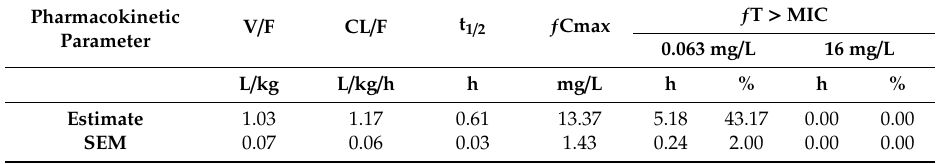
Table 2. Pharmacokinetic parameters of meropenem in rats with ESBL pneumonia–septicemia. Pharmacokinetic Parameter